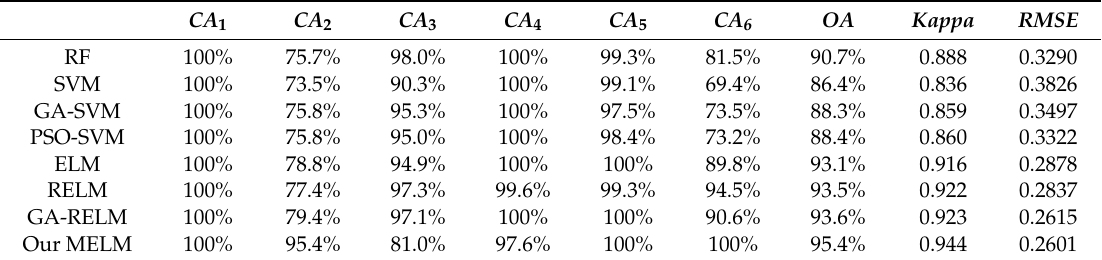
Table 5. The test set evaluation indexes of each classifier in the Z2